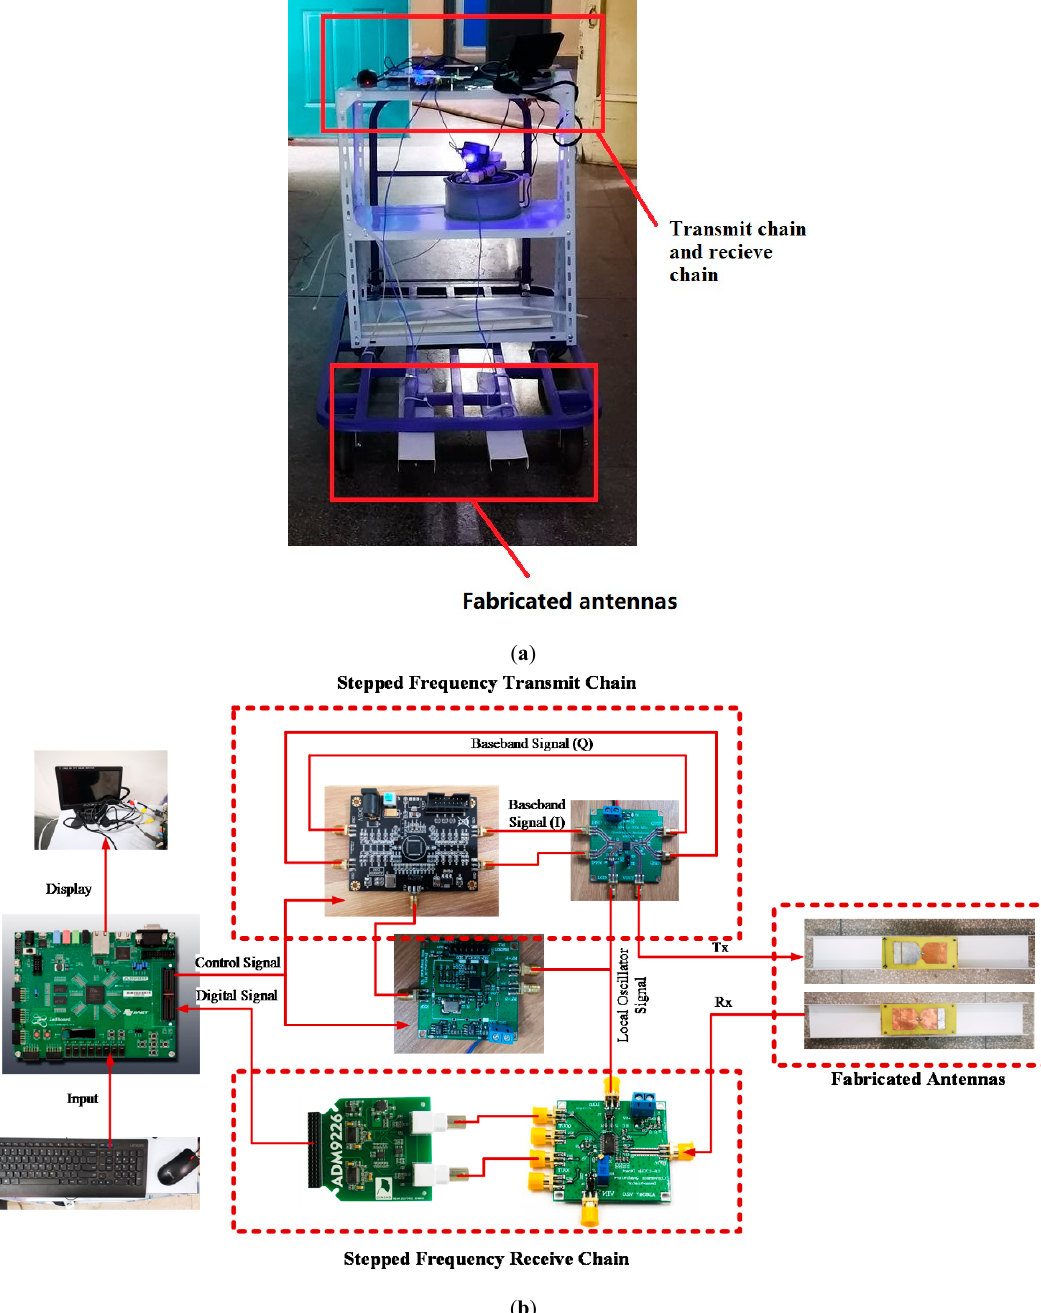
Figure 23. ( a ) The photo of experimental platform; ( b ) the transmit chain and receive chain is zoomed in this figure.